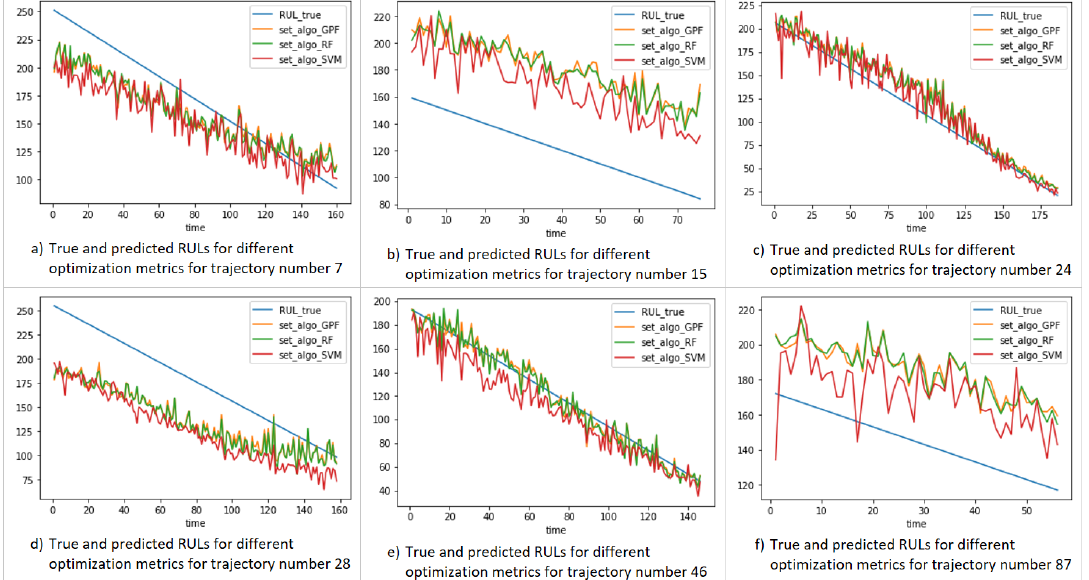
Figure 10. True and predicted value on dataset FD001 for six different trajectories when using the GPF, RF, and